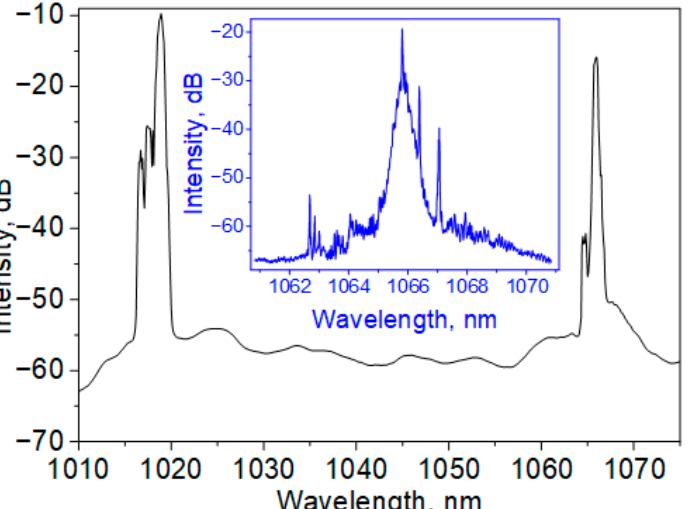
Figure 10. Output spectrum (40 W pump power) in 62.5- µ m GRIN fiber Raman laser with gain modulation. Inset: zoomed 2nd Stokes spectrum with better resolution.